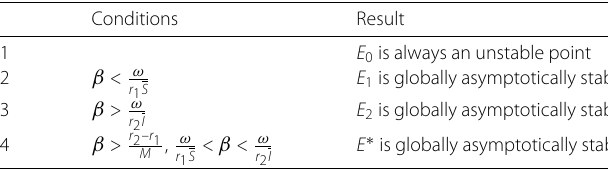
Table 2 Global results for system (2)